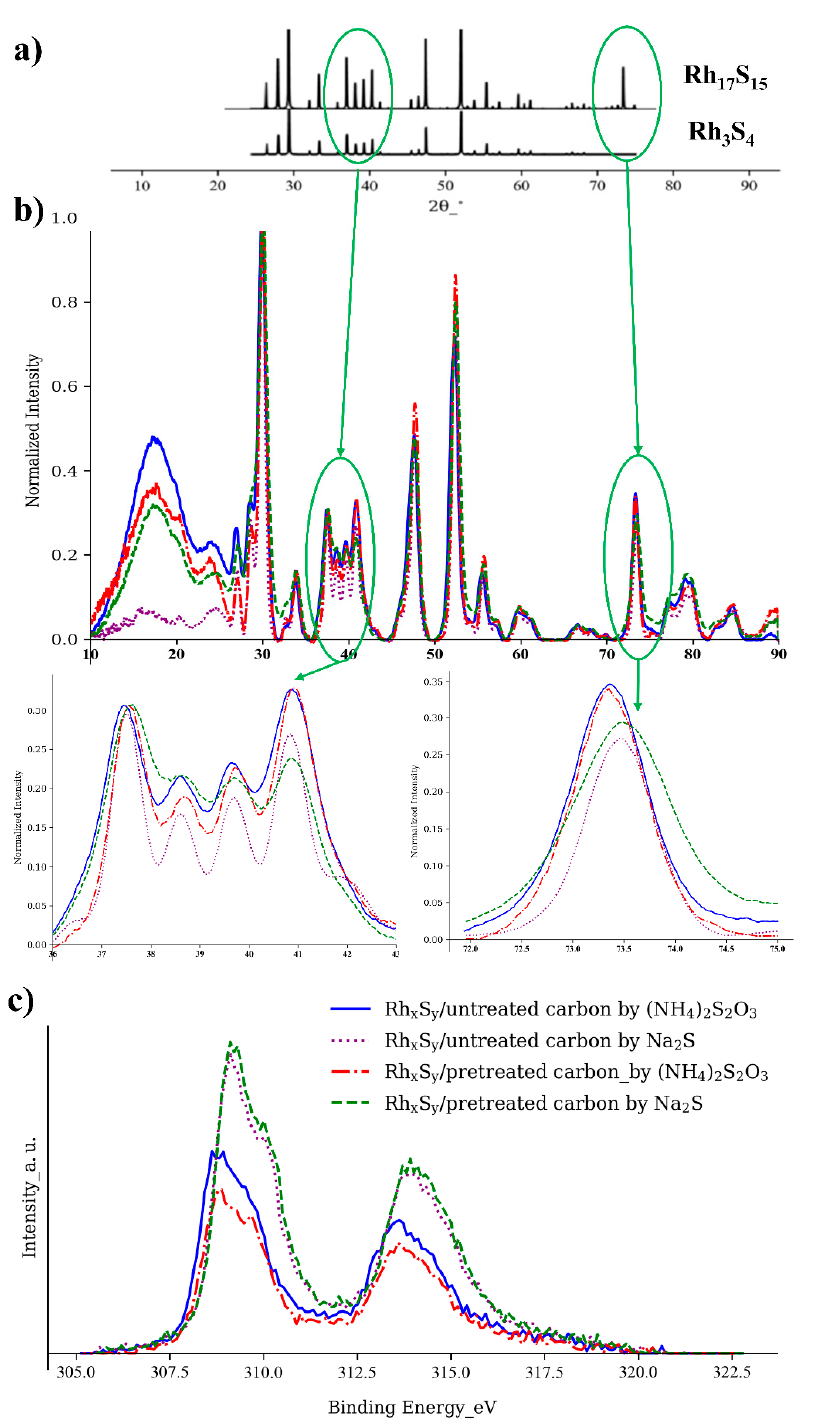
Figure 4. ( a ) Standard XRD spectra (Rh 3 S 4 ICDS No. 410813, Rh 17 S 15 ICDS No. 410838); ( b ) XRD spectra and ( c ) Rh 3d XPS of Rh x S y synthesized with different carbon substrates and sulfur sources.